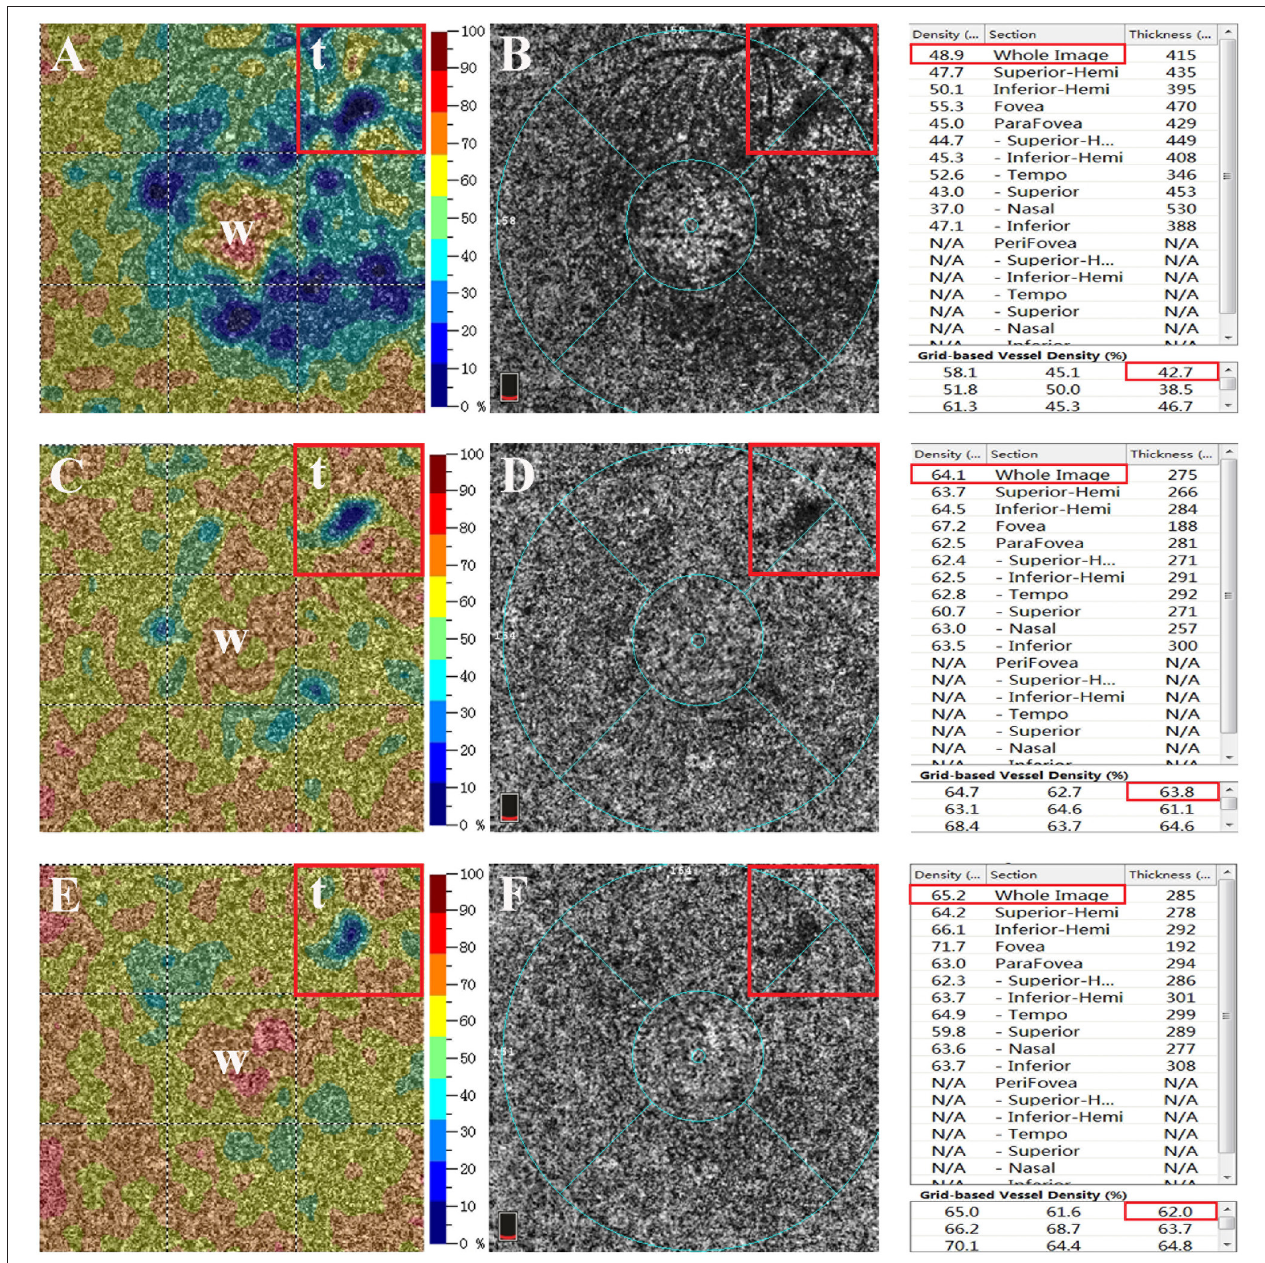
FIGURE 2 | Superficial choroidal layer on optical coherence tomographic angiography (OCTA) image. (A,B) The mean vessel densities of the whole area (area “ w ” in figure) and the target area (area “ t ” in figure) were measured (Vt and Vw, respectively). The mean vessel density ratio was calculated at each follow-up visit (vessel density ratio = Vt/Vw). (C,D) OCTA image of the superficial choroidal layer at the 1-month follow-up visit. (E,F) OCTA image of the superficial choroidal layer at the 3-month follow-up visit. The right panel shows the mean vessel density of the superficial choroidal layer at baseline and at 1 and 3 months and the mean vessel density in each subregion. The red box marks the vessel density of the whole area and the target area at the leakage point.